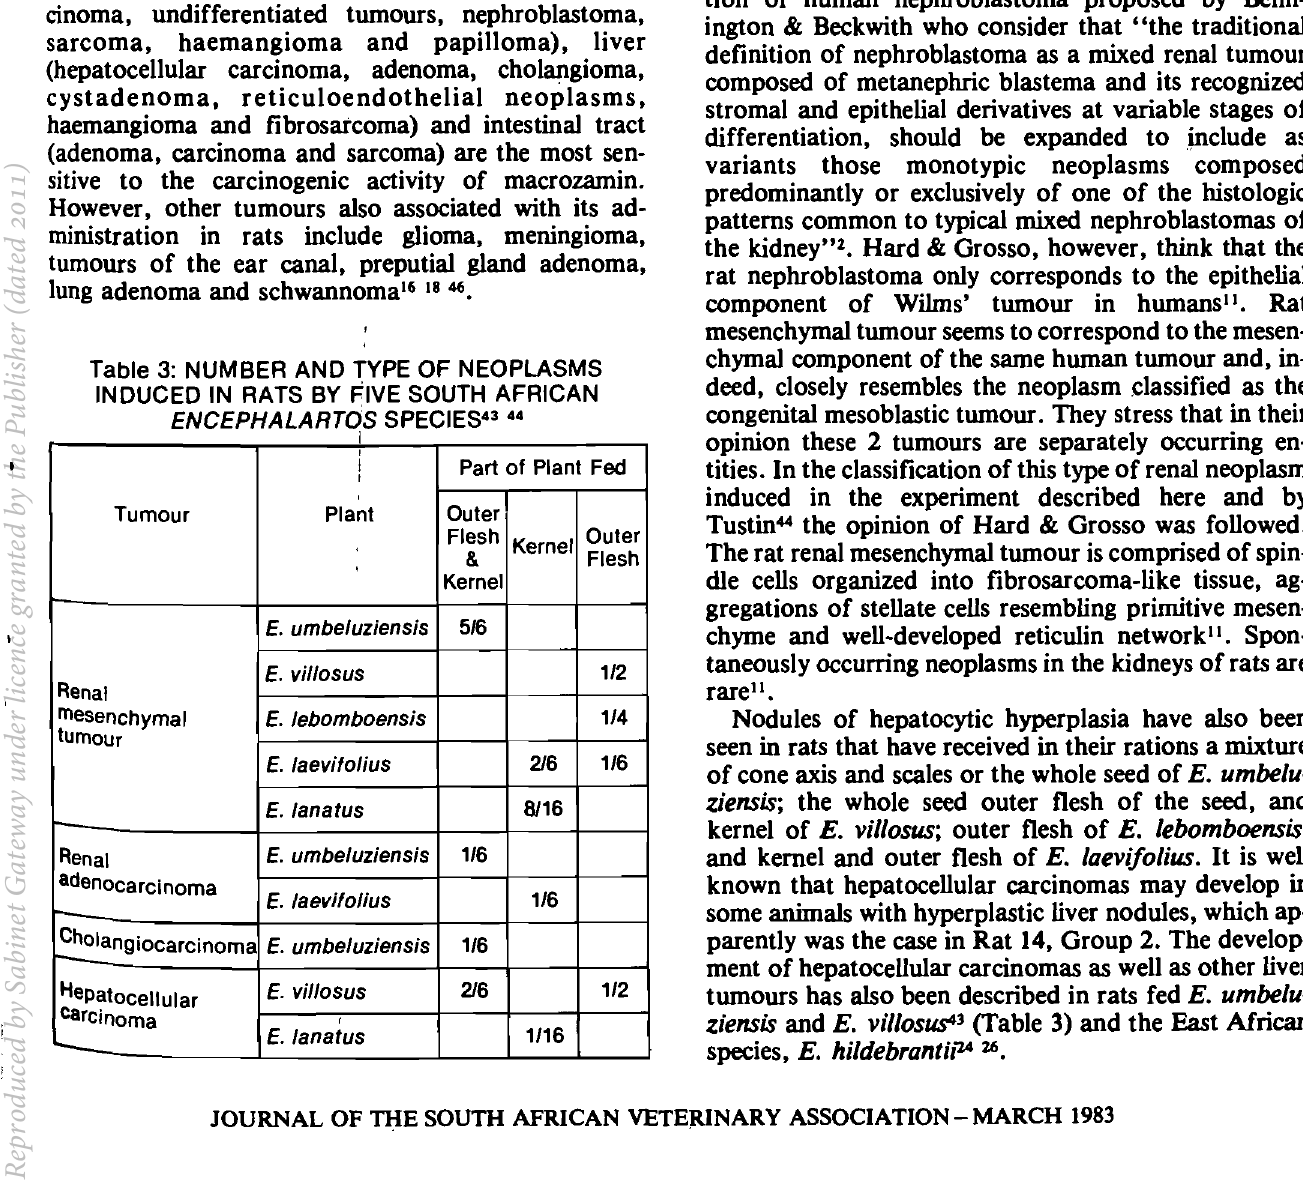
Table 3: NUMBER AND TYPE OF NEOPLASMS INDUCED IN RATS BY FIVE SOUTH AFRICAN ENCEPHALARTOS SPECIES43 44 I